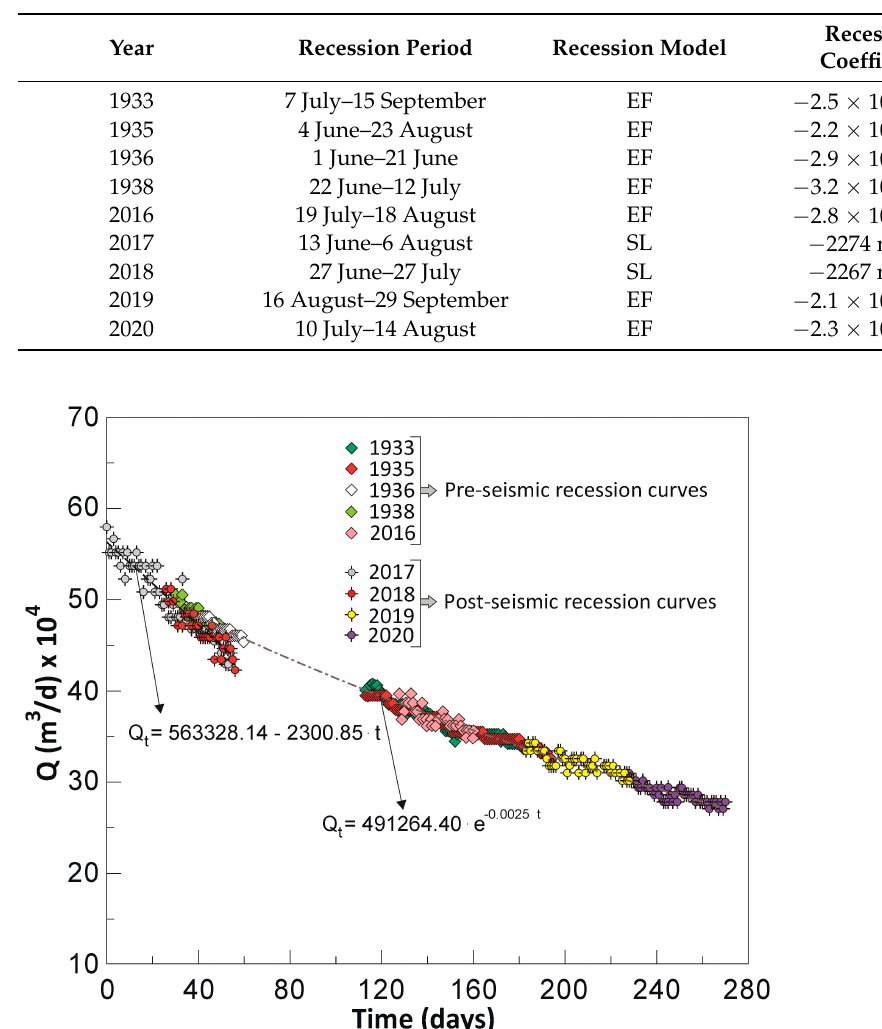
Table 3. Recession models that best describe the Nera River discharges (Section I1 in Figure 2) during the available recession periods.